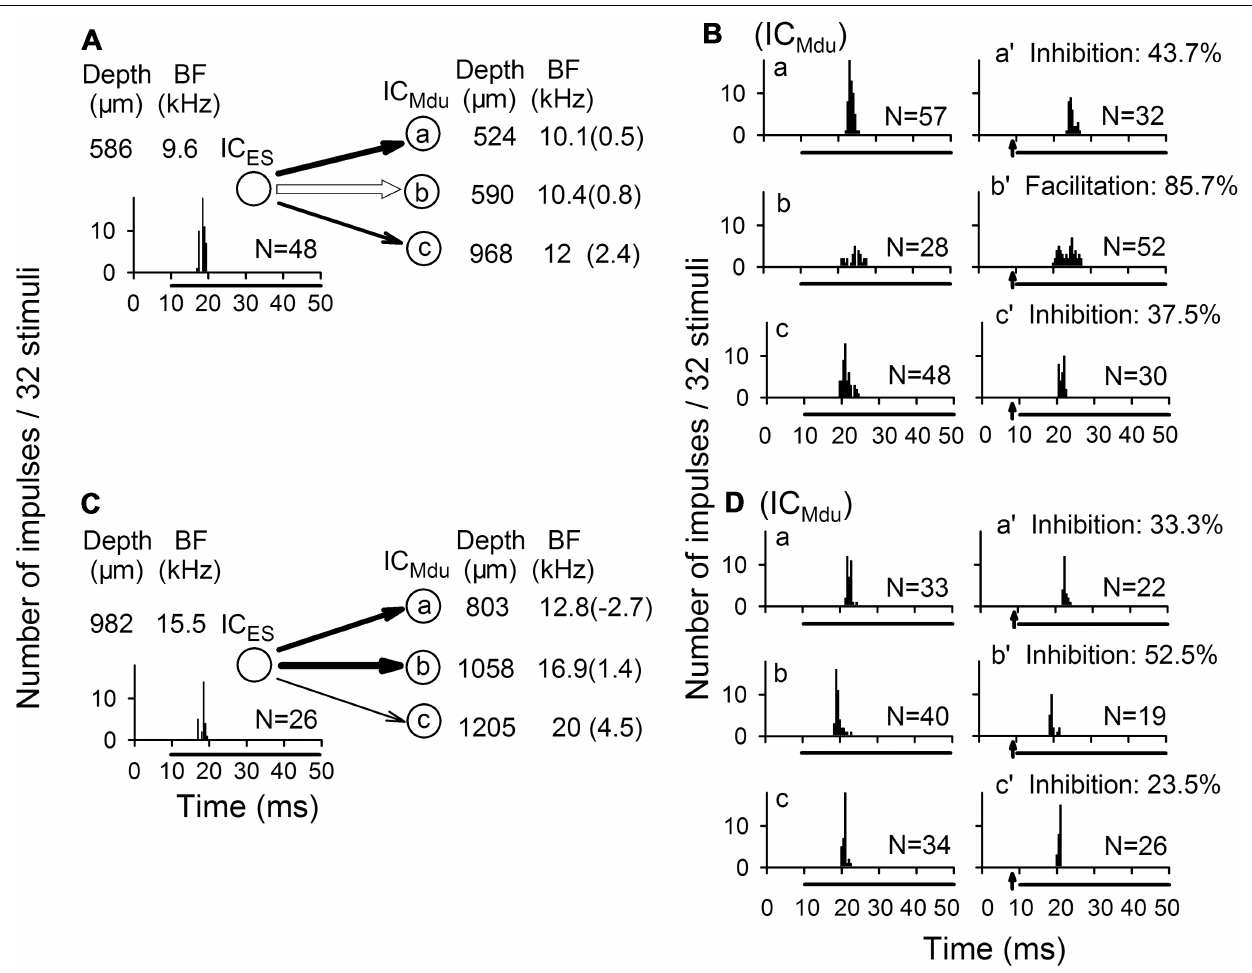
IC Mdu neurons studied.The BF of all six IC Mdu neurons progressively increased with recording depth, and the percent inhibition was closely correlated with BF difference. N, number of impulses; %, percent inhibition or facilitation; of response of each IC Mdu neuron. Arrow: focal electric stimulation (Mei etal.,